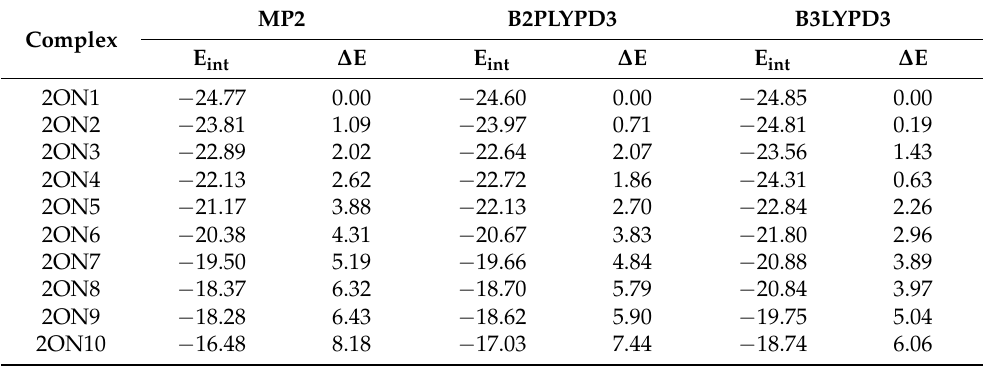
Figure 3. The MP2 optimized selected structures of the 2:1 HNCO complexes with N 2 . The positions of the bond (3, − 1) and ring (3,+1) critical points derived from AIM calculations are shown by small green and red circles, respectively. Table 4. The BSSE corrected interaction energies E int and relative energies ∆ E (kJ mol − 1 ) of the HNCO · · · N 2 complexes of the 2:1 stoichiometry calculated at MP2, B2PLYPD3 and B3LYPD3 levels with the 6-311++G(3df,3pd) basis